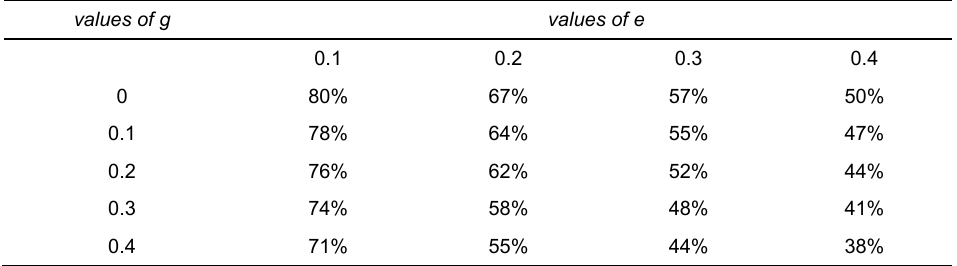
Table 3: The optimal top marginal tax rate as a function of g and e , with a = 2.5 values of g values of